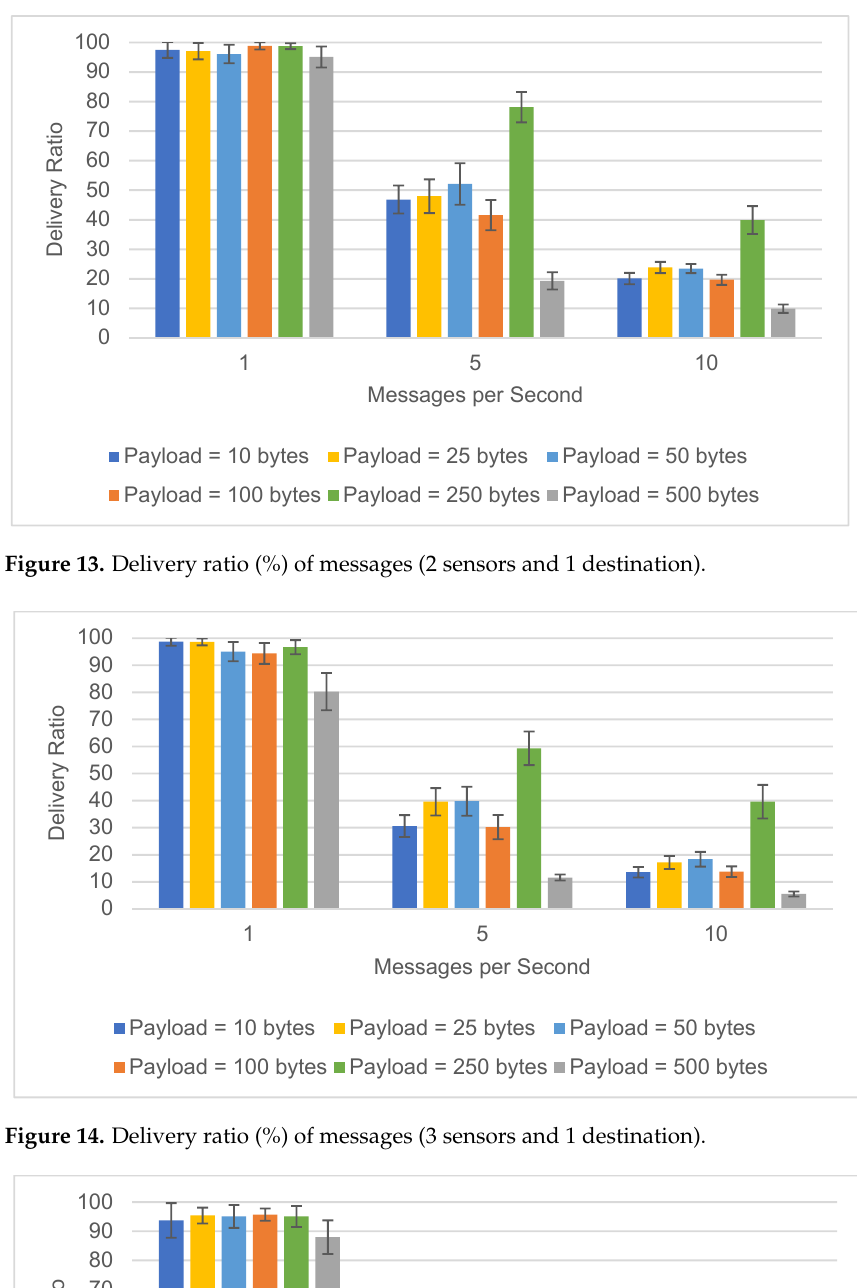
Figure 12. Delivery ratio (%) of messages (1 sensor and 1 destination).